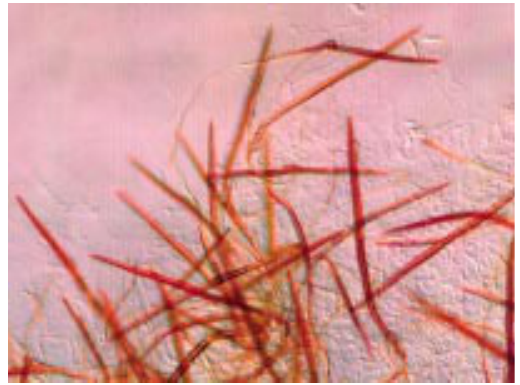
Fig. 7. Phellinus sp. (non P. punctatus ) isolated from esca-like heart rot – setae produced in MEA culture (VPRI